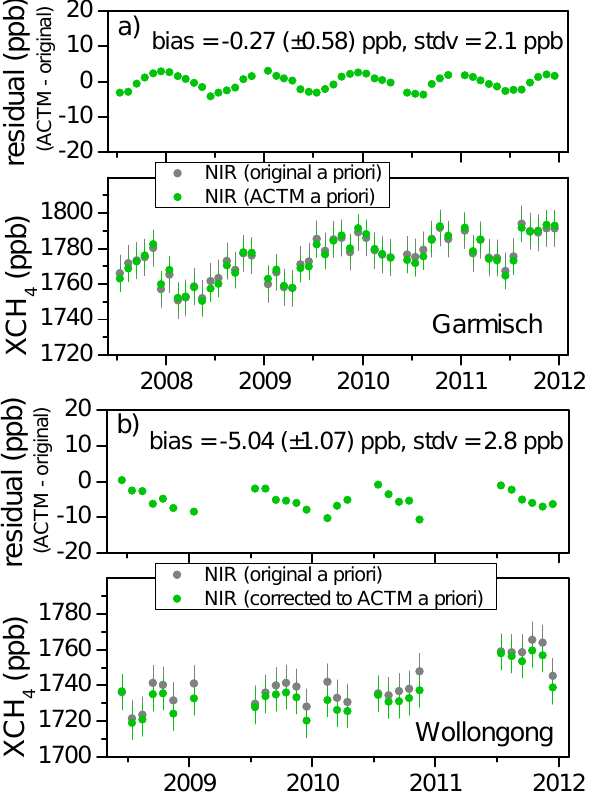
Fig. 3. (a) Lower trace: monthly mean time series of column- averaged methane retrieved from NIR spectral measurements at Garmisch – retrieved using the original (GFIT) a priori profile (grey) as well as the ACTM a priori profiles. The impact from changing the a priori profile is shown in the upper trace. Error bars are 2- σ uncertainites as explained in Fig. 4. Bias uncertainty is 2 √ n of the residuals. (b) Same as (a) but for Wollongong; green stdv/ points: data corrected to ACTM prior using Eq. (1). (2008 stands for 1 January 2008; the minor tic is 1